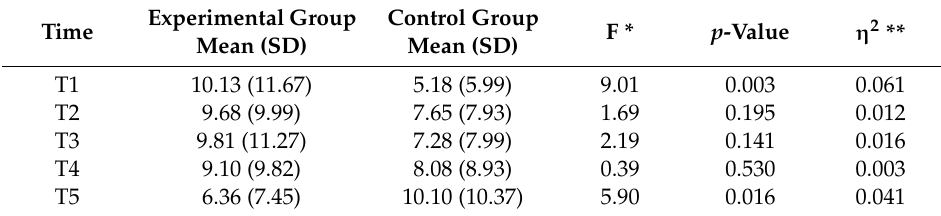
Table 2. Means and standard deviations of groups on the level of BPSD and univariate statistics